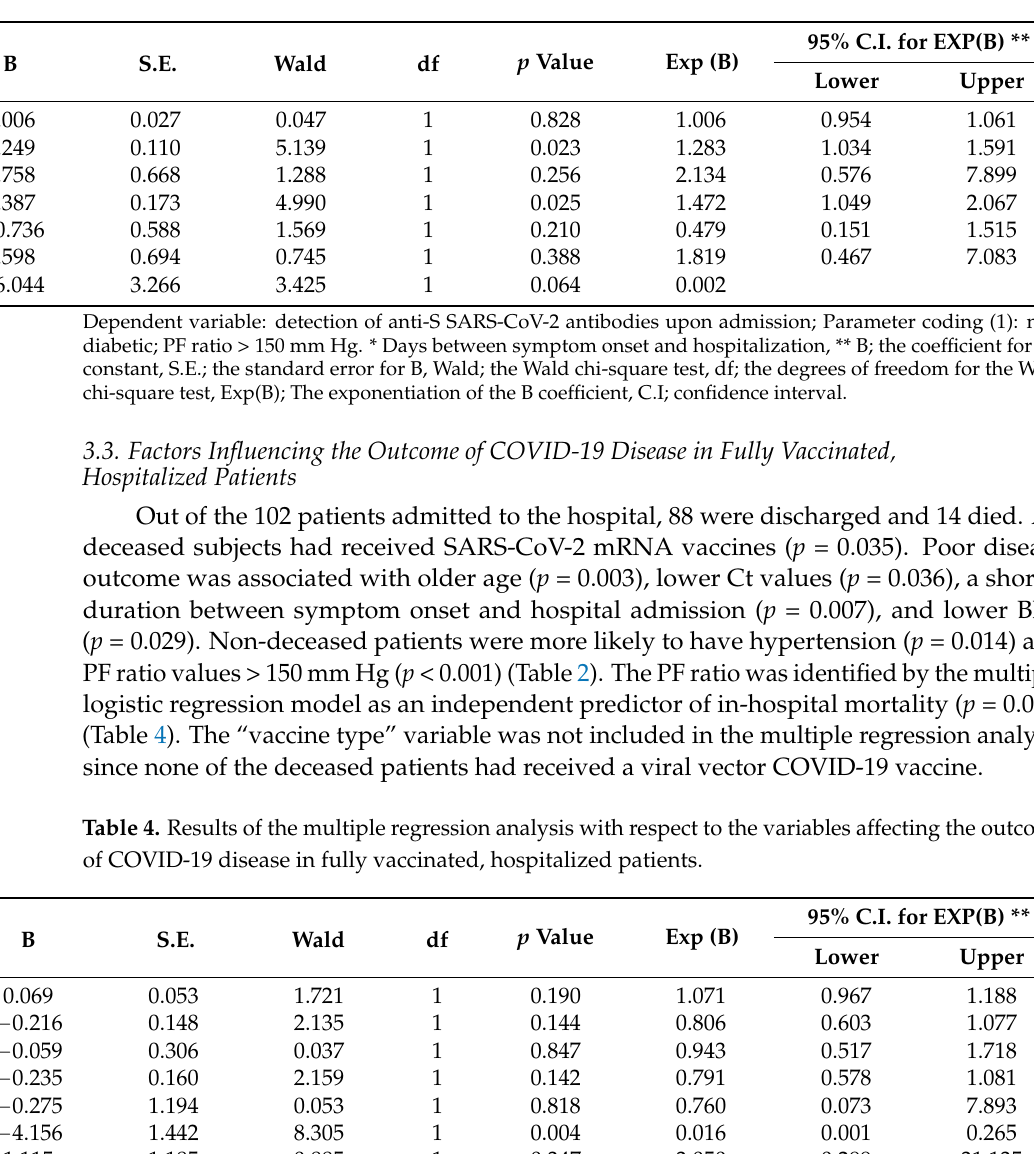
Table 3. Results of the multiple regression analysis with respect to the variables affecting the presence of anti-S SARS-CoV-2 antibodies upon admission.